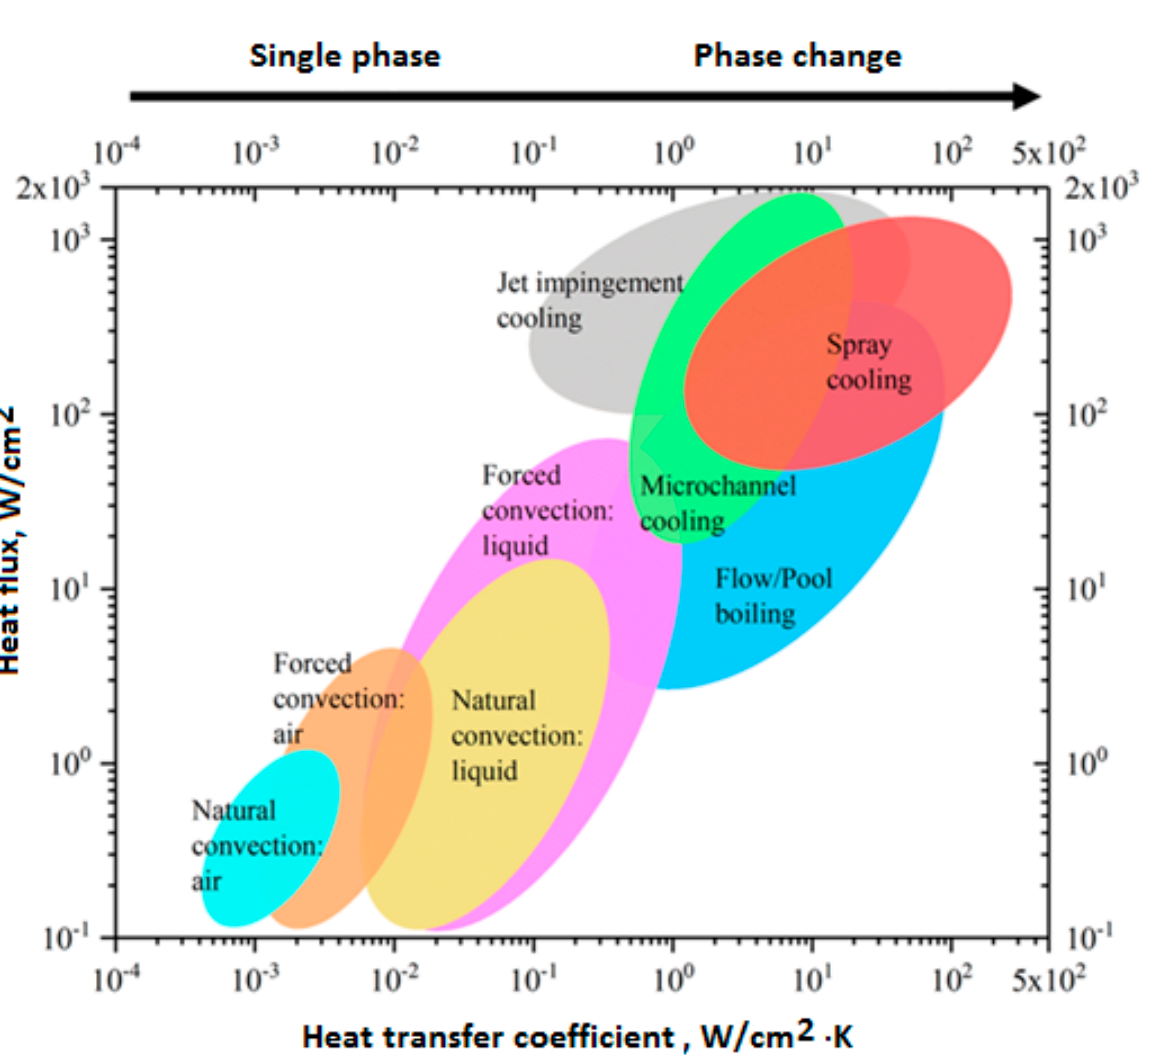
Figure 50. Classifying various cooling techniques according to the heat flux and heat transfer coefficient (adapted with permission from Ref. [158]. Copyright © 2022 Elsevier Ltd.)